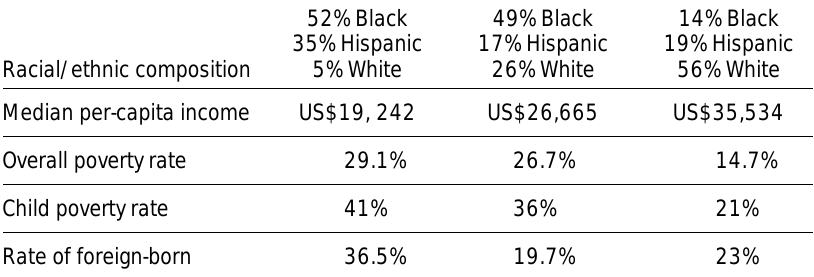
Table 1. Demographic data from neighborhoods where the Farmer Field Schools (FFSs) in this study were